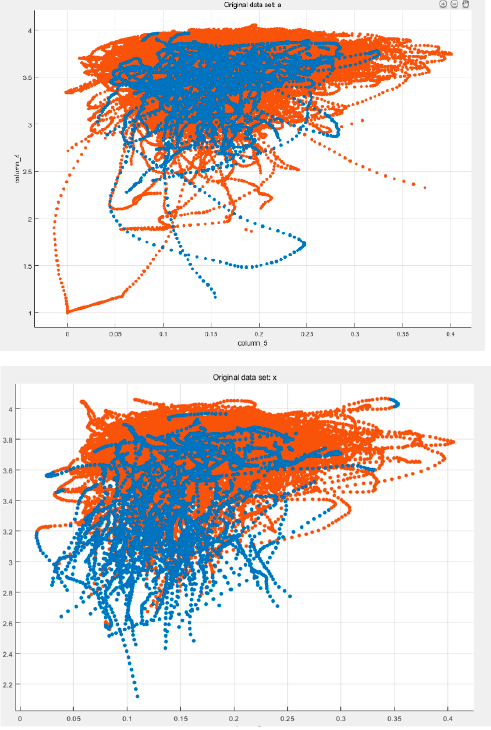
Figure 1. Bfactor(2STD)and fuzzy entropy before and after windowing. Table 4. Influence of window on the three learning algorithms results.